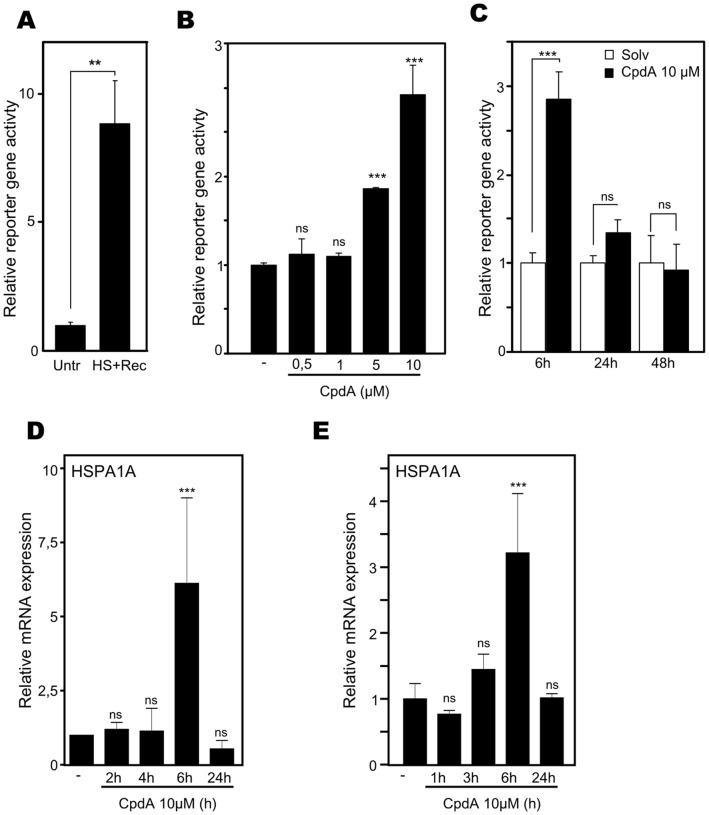
Compound A increases Hsp70 promoter activity dose-dependently and transiently.(A) L929sA cells, stably transfected with a mHsp70i-luc reporter gene construct, were left untreated (Untr) or were stimulated with heat shock at 43°C for 2h, followed by a recovery period of 2h at 37°C (HS+Rec). Normalized luciferase levels were presented as relative reporter gene activity with the condition ‘Untr’ set as 1. Statistical analysis (unpaired t-test) was performed. This figure is representative for 6 independent experiments. (B) L929sA cells, stably transfected with mHsp70i-luc, were induced for 8h with various concentrations of CpdA, as indicated. All samples were controlled to a similar amount of solvent. This figure is representative for 4 independent experiments. (C) L929sA cells, stably transfected with mHsp70i-luc, were treated with solvent (Solv) or CpdA (10µM) for 6h, 24h or 48h. Data were presented as relative reporter gene activity with the Solv condition set as 1. Statistical analysis (ANOVA with Tukey’s multiple comparison post test) was performed to explore if Solv differs from CpdA treatment for each respective induction time. (D) A549 cells, were treated with solvent or CpdA 10µM for the indicated time period. Total cellular mRNA was subjected to RT-qPCR detecting gene expression levels for HSPA1A, normalized using housekeeping 36B4 and β-actin mRNA levels. Four independent experiments with slightly varying time kinetics all show comparable results. (E) PC-3 cells were starved for 48h in 0% DMEM, after which these cells were left untreated or treated with Compound A (10µM), as indicated. Purified mRNA was subjected to RT-qPCR detecting HSPA1A gene expression levels and specific results were normalized to housekeeping controls cyclophilin, GAPDH and 36B4. (B)(D)(E) Solv condition was set as 1 and results recalculated accordingly. Statistical analysis (ANOVA with Tukey’s multiple comparison post test) was performed to compare with Solv (ns not significant; ** p<0.01; *** p<0.001).